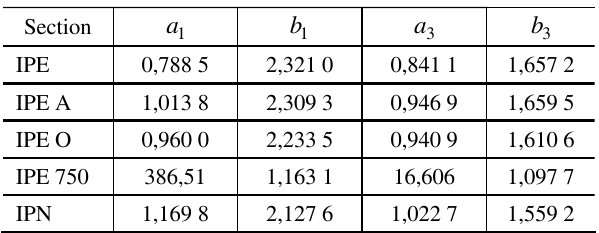
Table 1. Coefficients of relations (35)